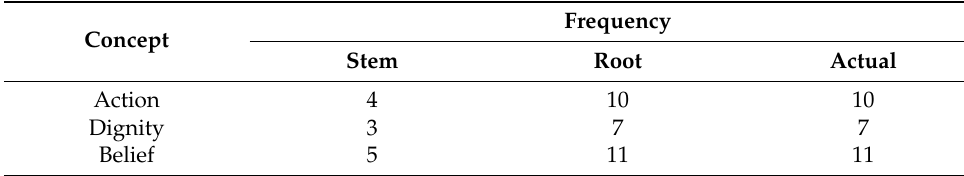
Table 12. Frequency of stem and root in a sample